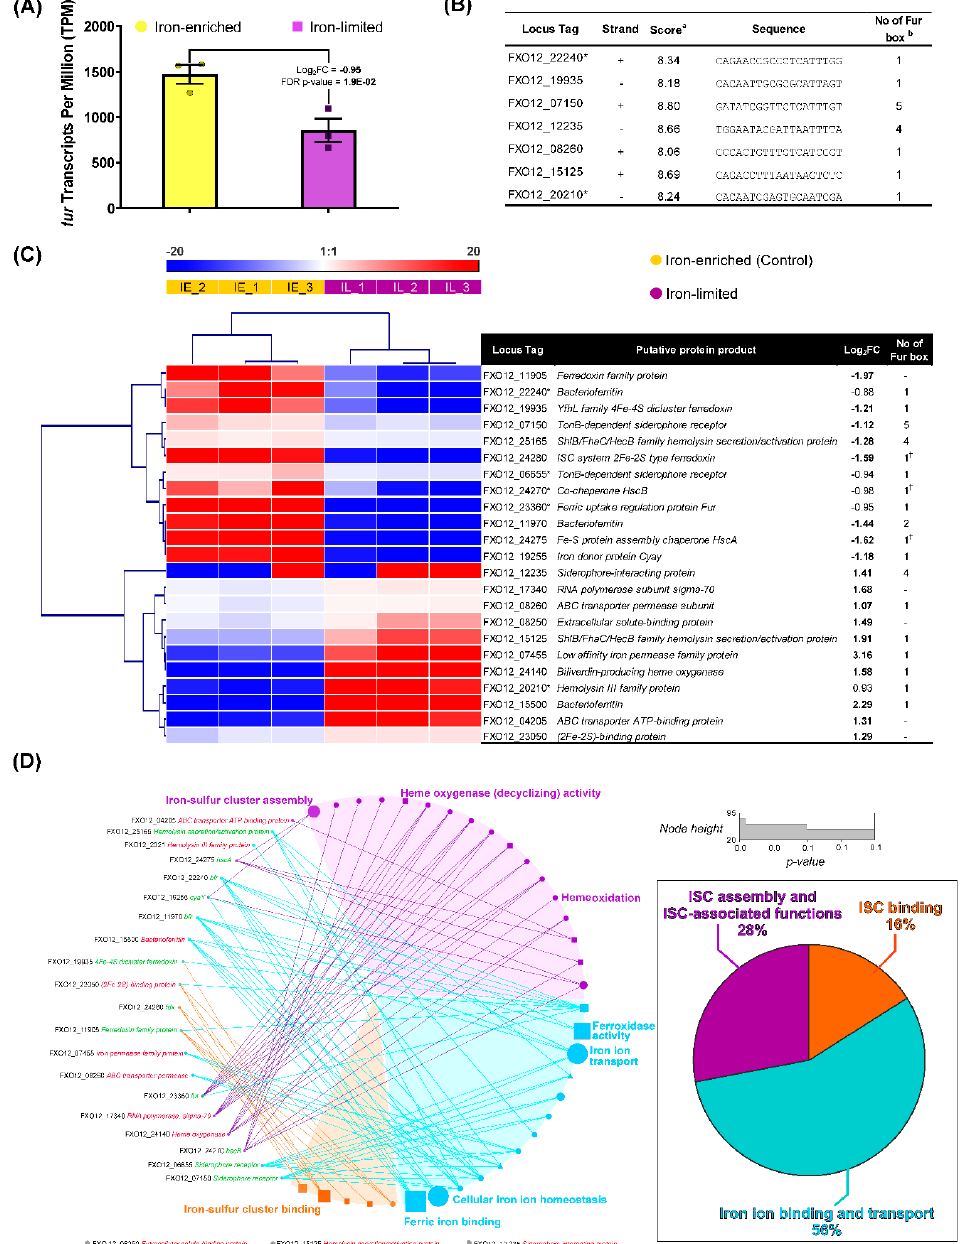
Figure 8. Putative elements associated with iron homeostasis in Pseudomonas sp. J380 identified by RNA-Seq under iron-limitation. ( A ) Number of fur (Ferric uptake regulation protein; FXO12_23360) transcripts under iron-enriched and iron-limited conditions. ( B ) Selected genes harboring predicted Fur box sequences. a, predictive score provided by regulon analyses using Virtual Footprint tool [50]. This inset table only shows Fur boxes with a score >8.0; b, when a gene contains more than one Fur box, the one with the highest score is shown. ( C ) Heat map illustration of genes with the putative function in iron homeostasis. †, part of the isc operon (Figure S12); -, no Fur boxes detected; FC of DEGs is in bold. *, refer to Table 3 footnote. ( D ) Gene Ontology (GO) term enrichment and pathway term network analysis of genes associated with iron homeostasis. GO enrichment analysis was performed with ClueGO [48]. Inset pie chart summarizes % genes per GO group. The circular pictogram is divided into left and right halves for genes and GO terms, respectively, in which the functionally grouped GO terms share the same color. The shape of the nodes indicates specific GO modules (i.e., ellipse, BP; triangle, MF; rectangle, CC). Names of the up- and down-regulated genes are indicated in red and green, respectively. As shown in the legend, node height reflects the term p -value corrected with Bonferroni step down method. Three genes that are not connected with any GO terms are shown below the circular pictogram. Refer to the File S1 for